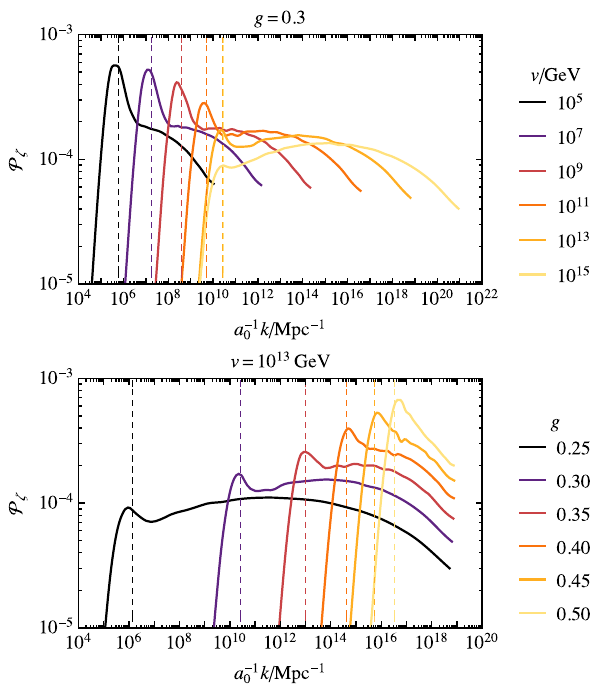
Fig. 4 The solid curves show the curvature power spectrum generated during the stage of thermal inflation and the vertical dashed lines indi- cate the scales k = k ds that exit the horizon when the false vacuum becomes